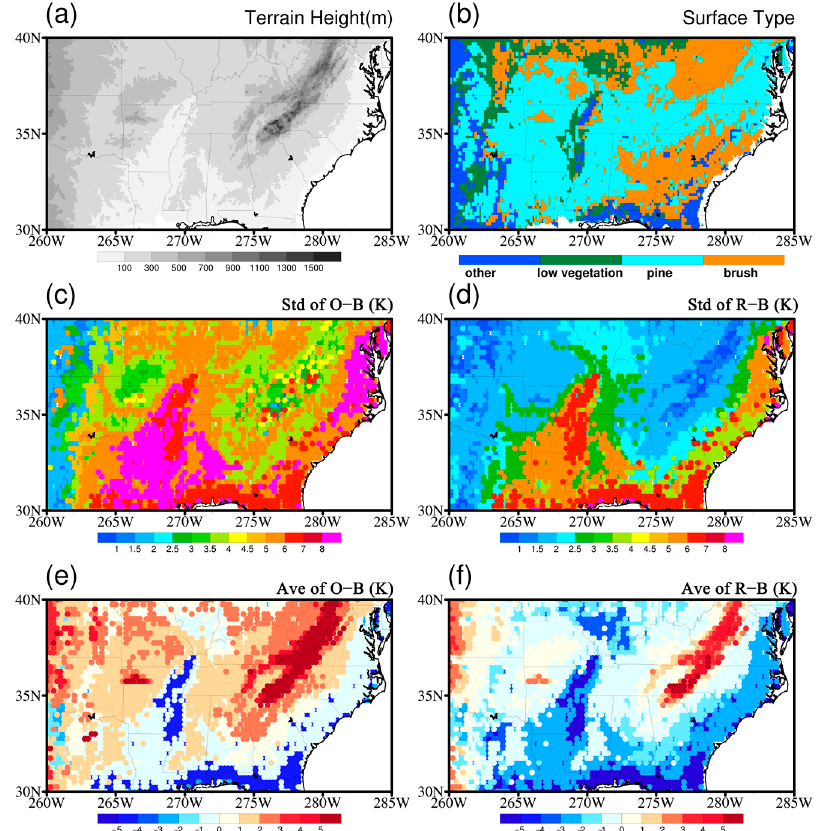
Figure 9. Spatial distributions of the terrain heights ( a ), surface types ( b ), standard deviations ( c , d ), and bias ( e , f ) before ( c , e ) and after the restoration ( d , f ) in the analyzed land area.